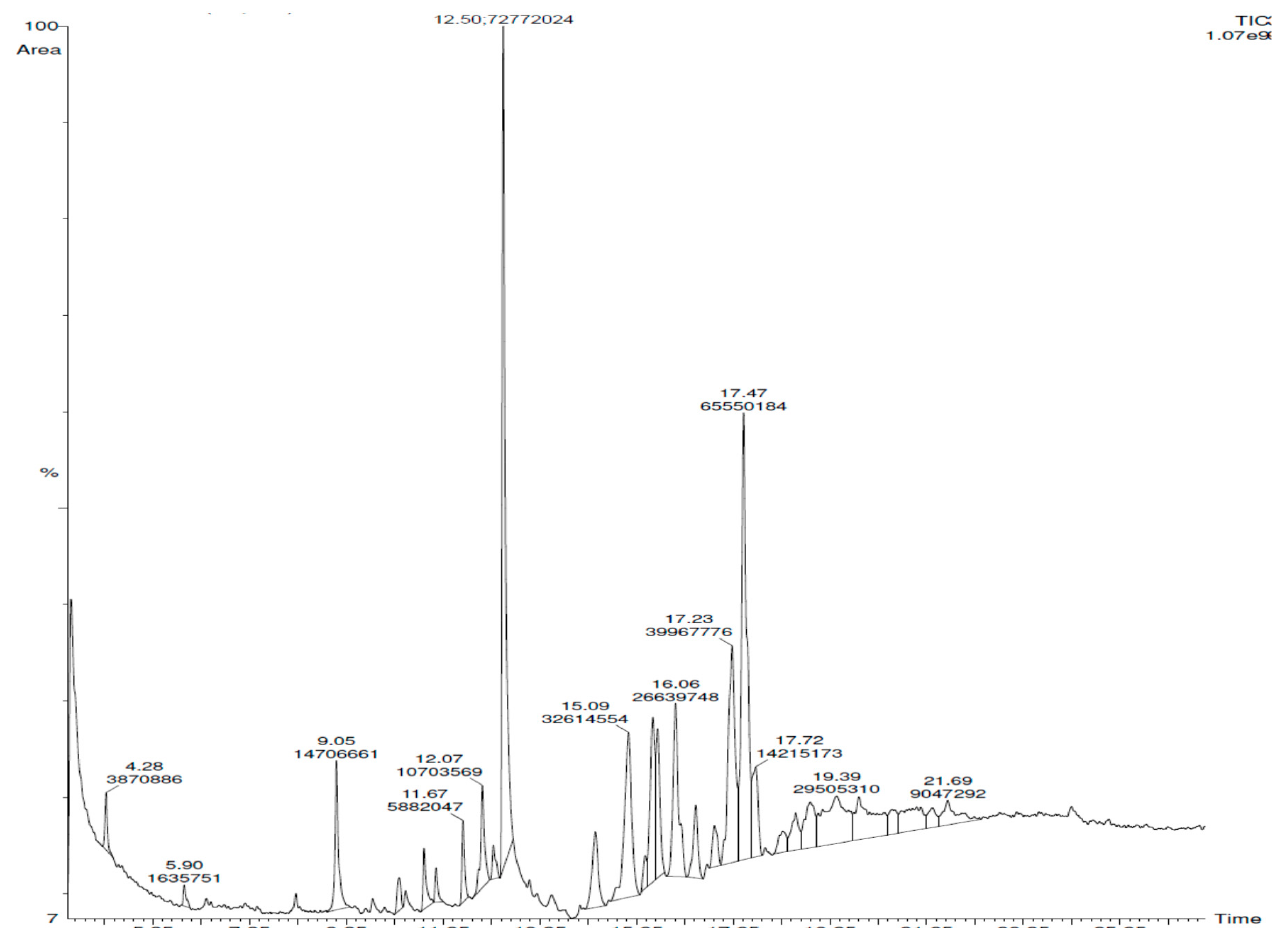
Figure 2. Major constituents found in n-butanol S. lappa root extract.